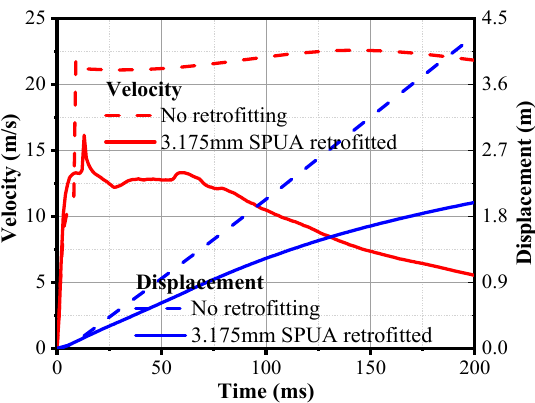
Figure 8. Velocity- and displacement-time histories in Test 2.